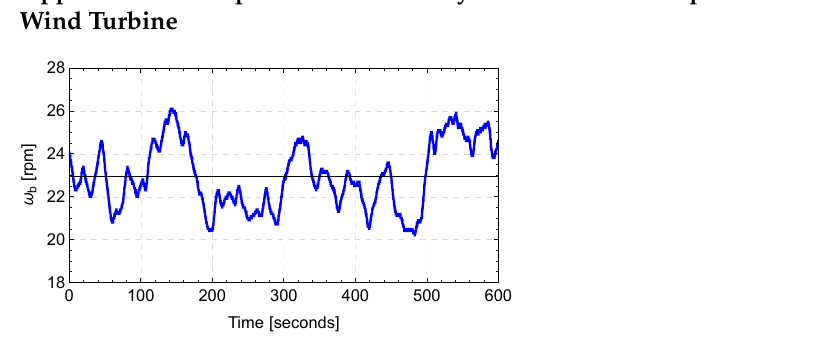
Figure A1. Example of the 50 Hz time series of the rotational speed of the wind turbine’s rotor for a case with a free inflow.